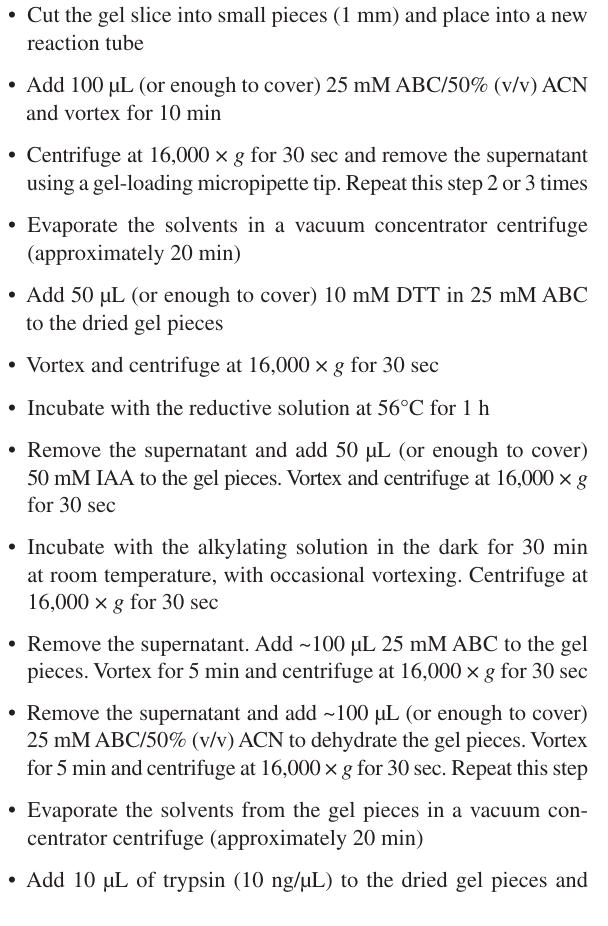
Protocol 3: Filter-aided sample preparation